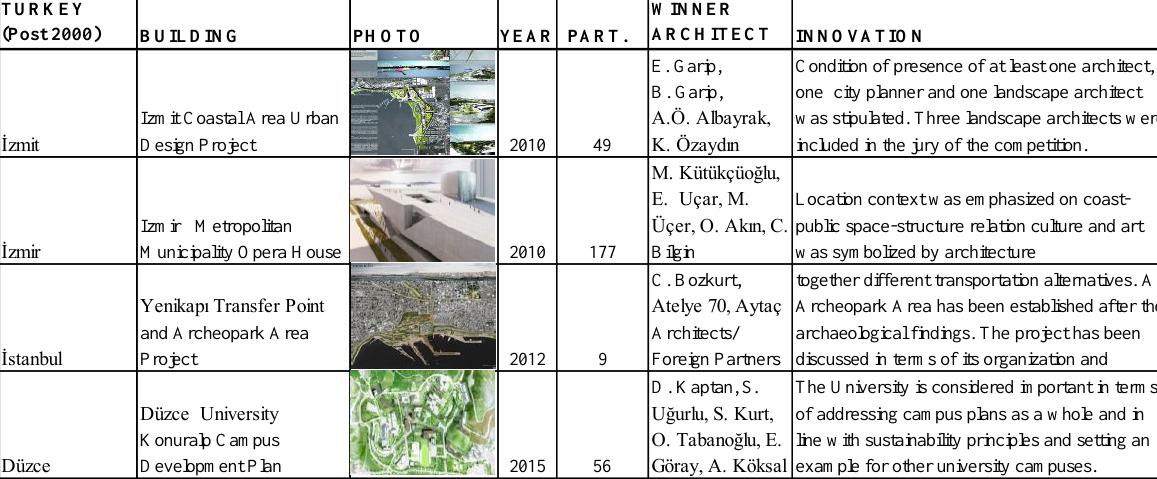
Table 9 . Selected competition examples of post 2000 period T UR K E